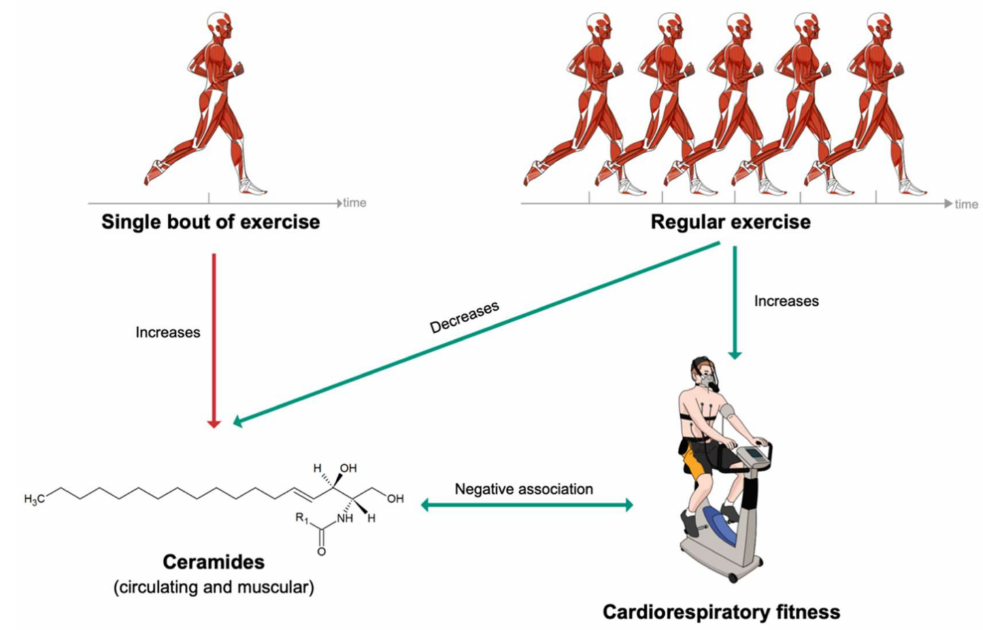
Figure 4. Short- and long-term effects of exercise on ceramide